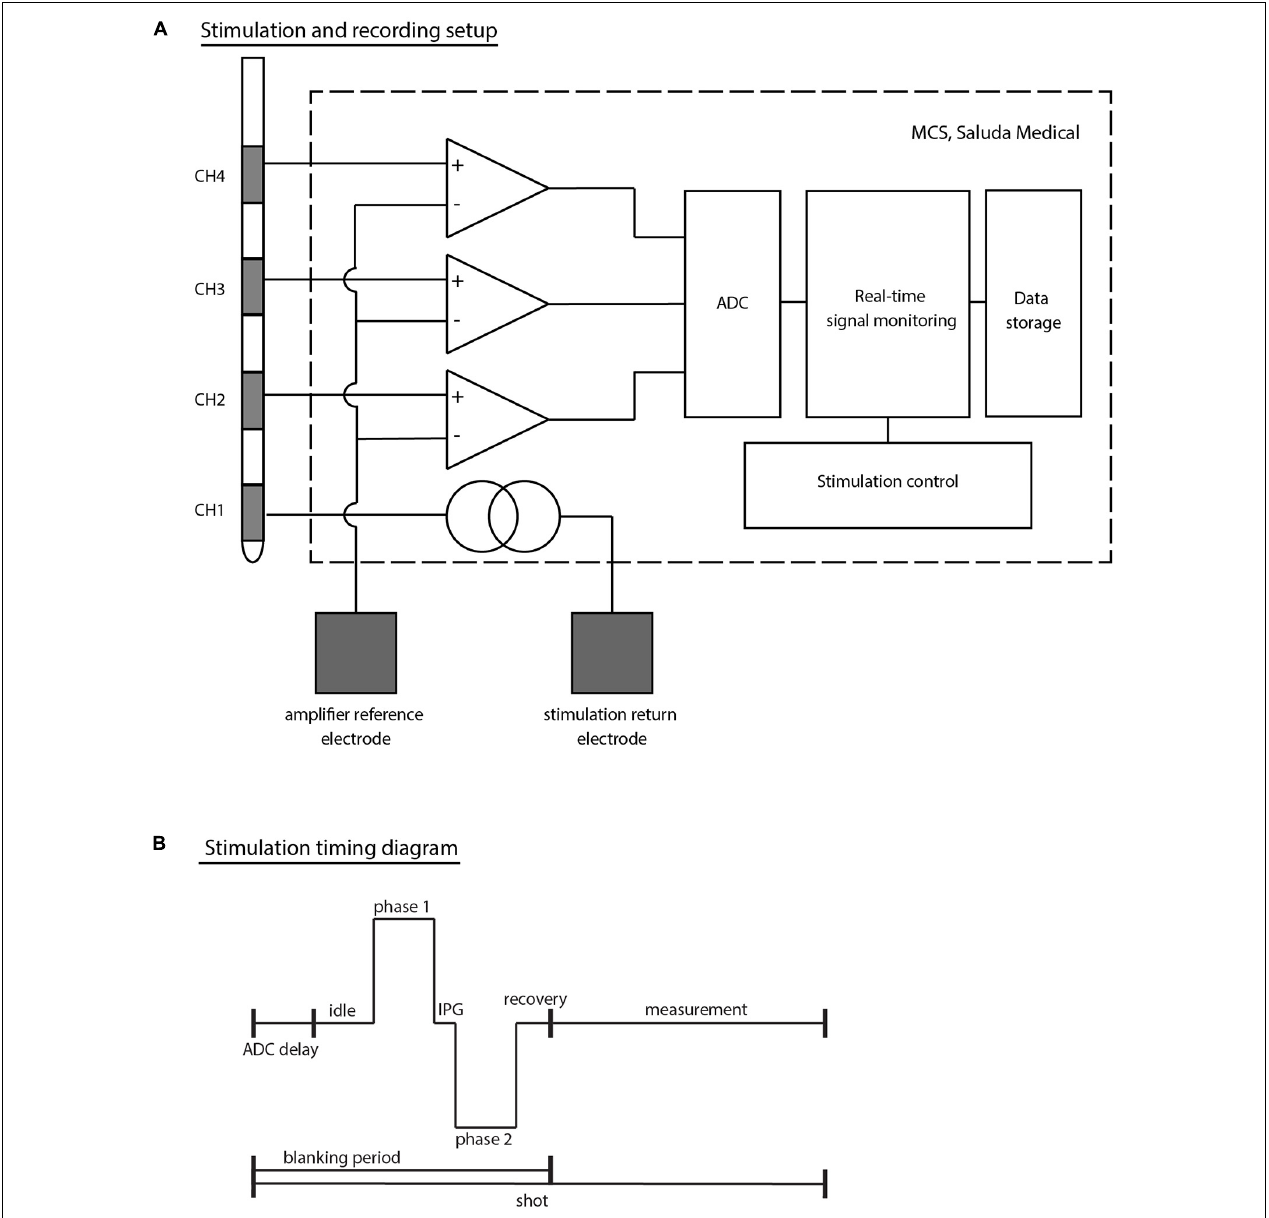
FIGURE 1 | (A) Schematic top-level representation of the stimulation and recording setup. The example given corresponds to a setup in which stimulation is applied on CH1 (most distal electrode of a Medtronic 3889 SNS lead) and electrophysiological recordings taken from CH2 to CH4 simultaneously. Both the stimulation return electrode and the amplifier reference channel (common to all amplifiers) are external electrodes (either adhesive carbon rubber pads or subdermal needle electrodes). (B) Timing diagram of stimulation outlining the stimulation sequence. Each stimulus and recording sequence is stored in shots. The amplifiers are blanked during the stimulation phase and for short periods before and after stimulation to avoid saturation of the electronics. The MCS design with the choice of ADC leads to a short (753 µ s) delay at the beginning of each shot prior to the first stimulus phase. IPG denotes the inter-phase gap in this